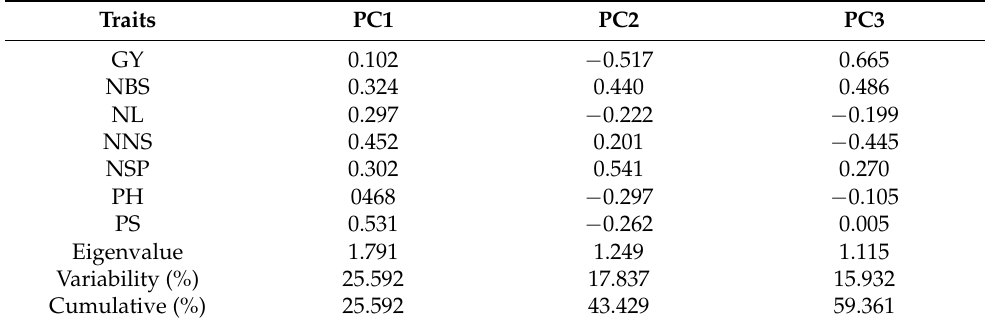
Table 6. Eigenvectors from principal component (PC) analysis for the 100 bambara groundnut